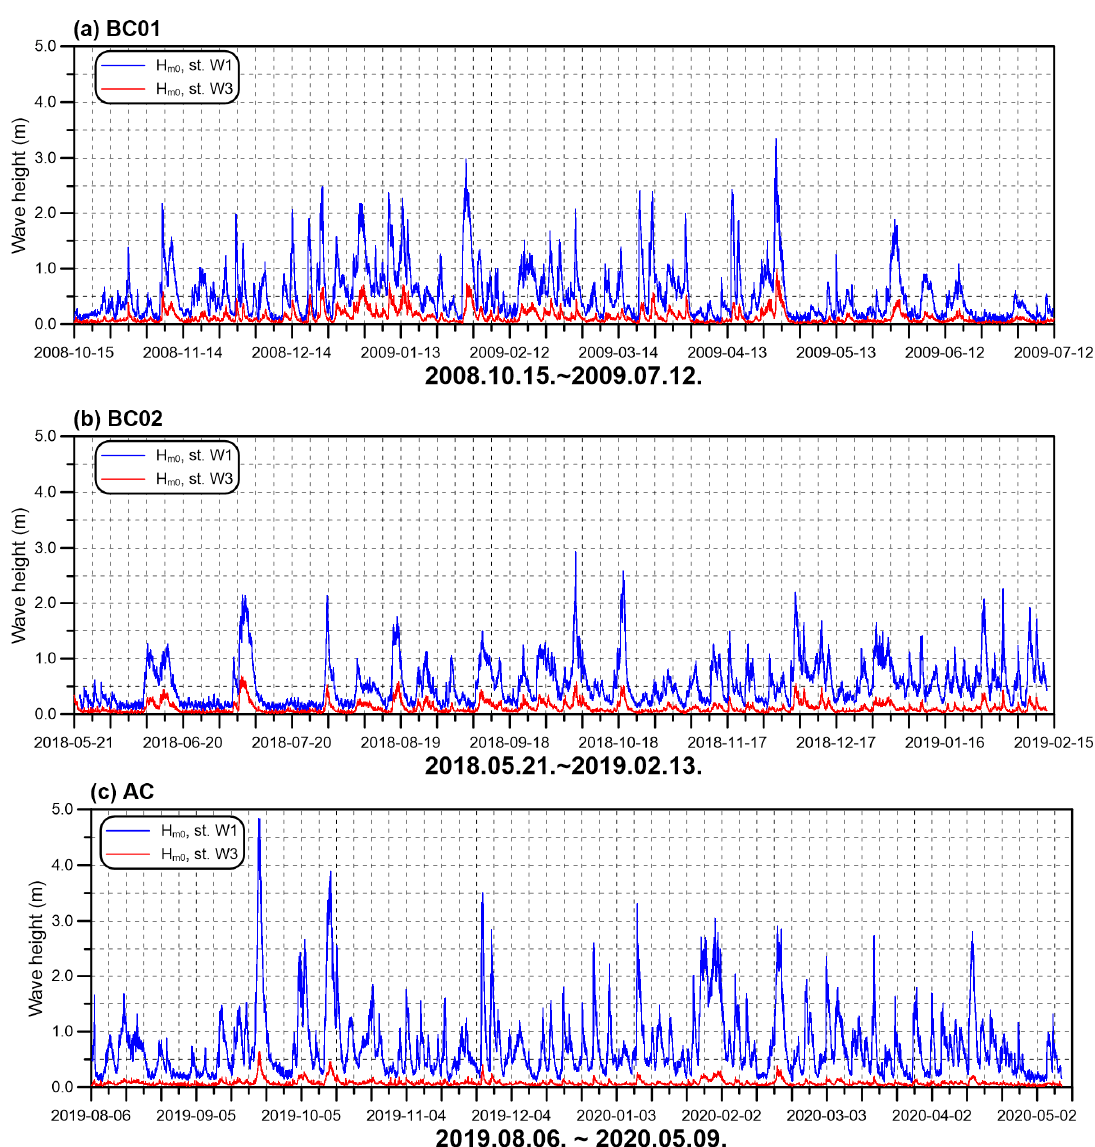
Figure 2. Comparison of H m 0 in W1 (blue) and W3 (red): ( a ) first period before detached breakwater construction (BC01) in 15 October 2008–12 July 2009, ( b ) before detached breakwater construction (BC02) in 21 May 2018–13 February 2099, and ( c ) after detached breakwater construction (AC).